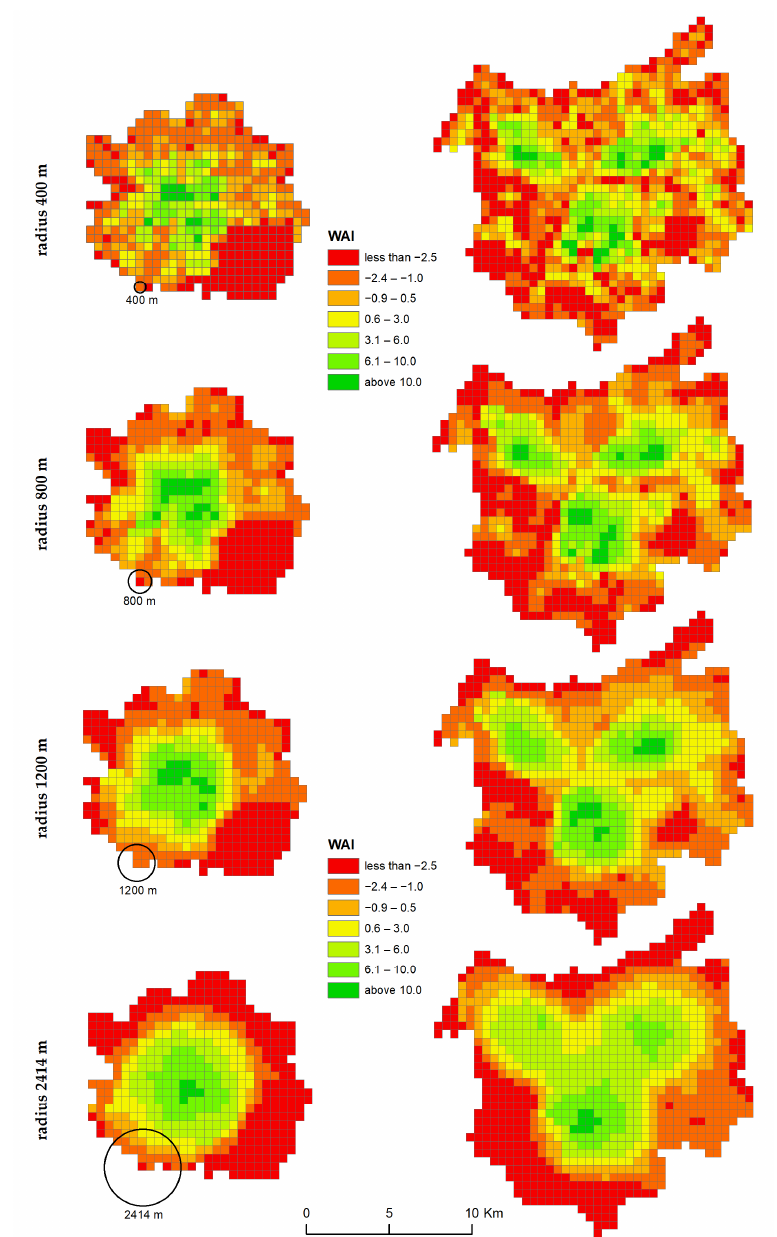
Figure 4. WAI for different buffers in Hradec Kralove ( left ) and Ostrava ( right ).